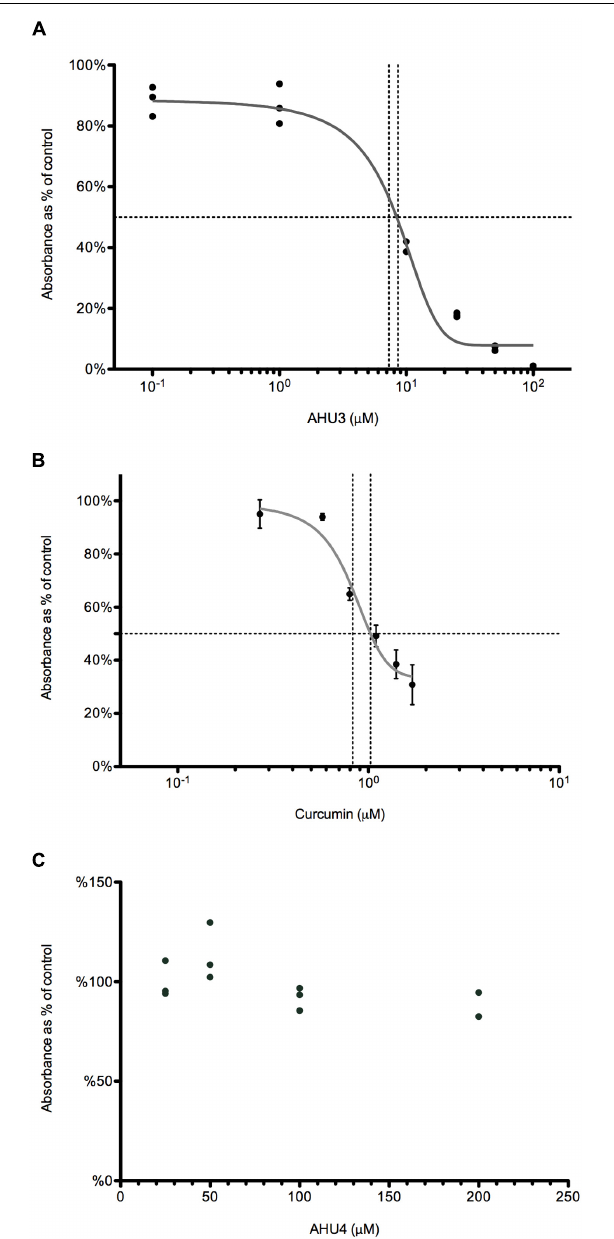
FIGURE 6 | AHU3 inhibits RecA-mediated ATP hydrolysis. (A) Dose-response curve for AHU3 showing the inhibition of ATPase activity with 0.1 − 100 µ M AHU3. Data are plotted as a percentage of the average absorbance of the assay wells containing 0 µ M AHU3. The curve exhibits an IC 50 value of 7.72 µ M and a Hill slope of 0.109. (B) Dose-response curve for curcumin showing the inhibition of ATPase activity with 0.1 − 100 µ M curcumin. The curve exhibits an IC 50 value of 6.69 µ M and a Hill slope of 2.400. (C) Dose-response curve for AHU4 showing no inhibition of ATPase activity.